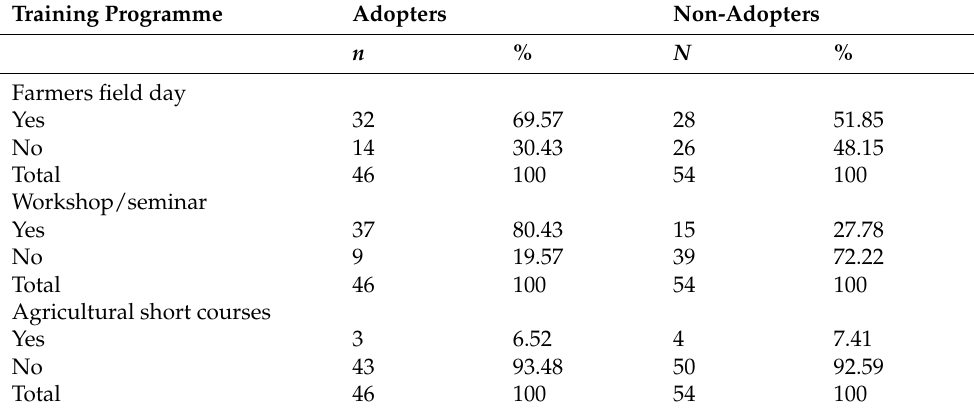
Table 9. Types of agricultural training programmes undertaken by